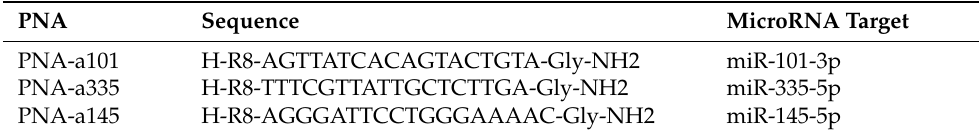
Table 1. PNA sequence employed in Calu-3 cells